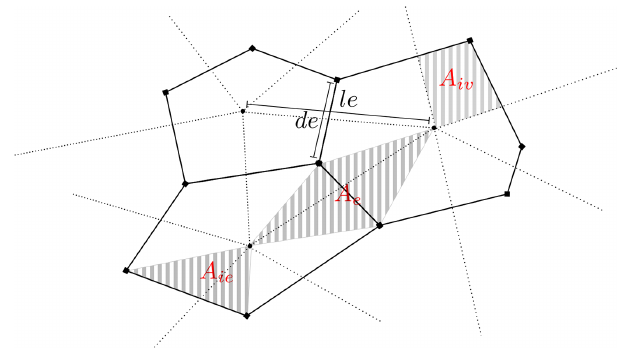
Figure A1. The geometric quantities on a planar grid. Primal grid edge lengths are denoted as “de”, dual grid edge lengths are denoted as “le”, the area associated with an edge by A e , the overlap between primal grid cell i and edge e by A ie , and the overlap between dual grid cell v and edge e by A iv . Note that the same definitions can be used on a spherical grid, provided the appropriate measures are used (such as geodesic lengths for distances, and spherical polygo- nal areas for areas). See Weller (2014) for more